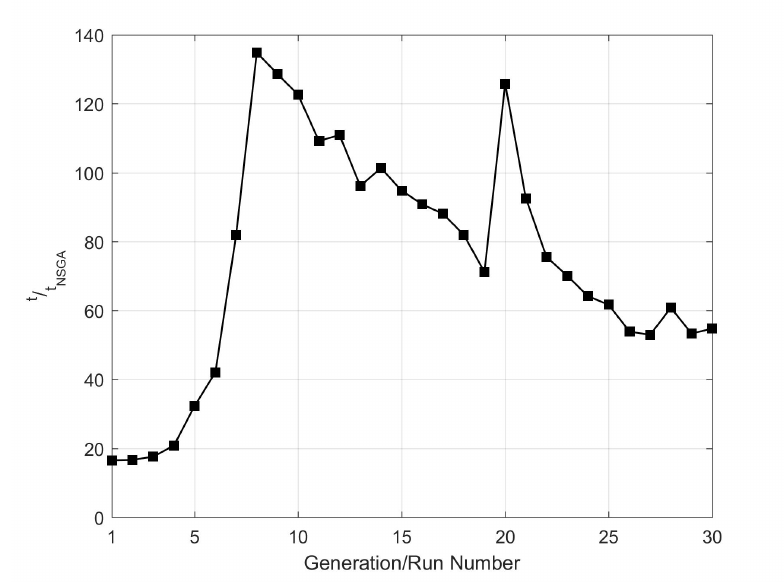
Figure 12. Ratio of average solution evaluation